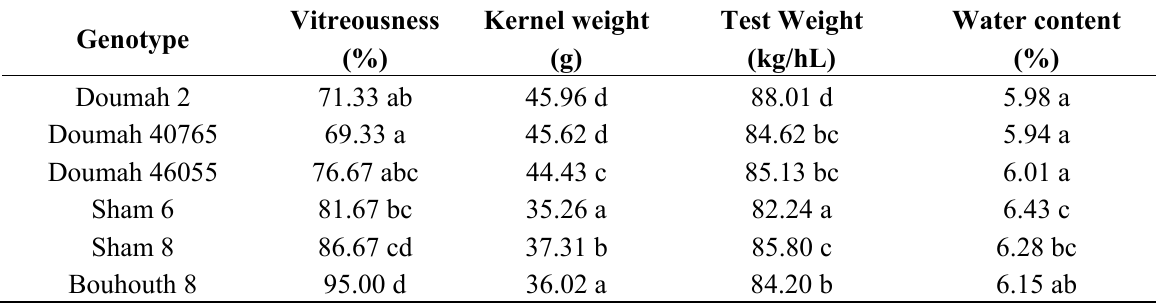
Table 3. Selected physical characteristics of Syrian wheat samples.